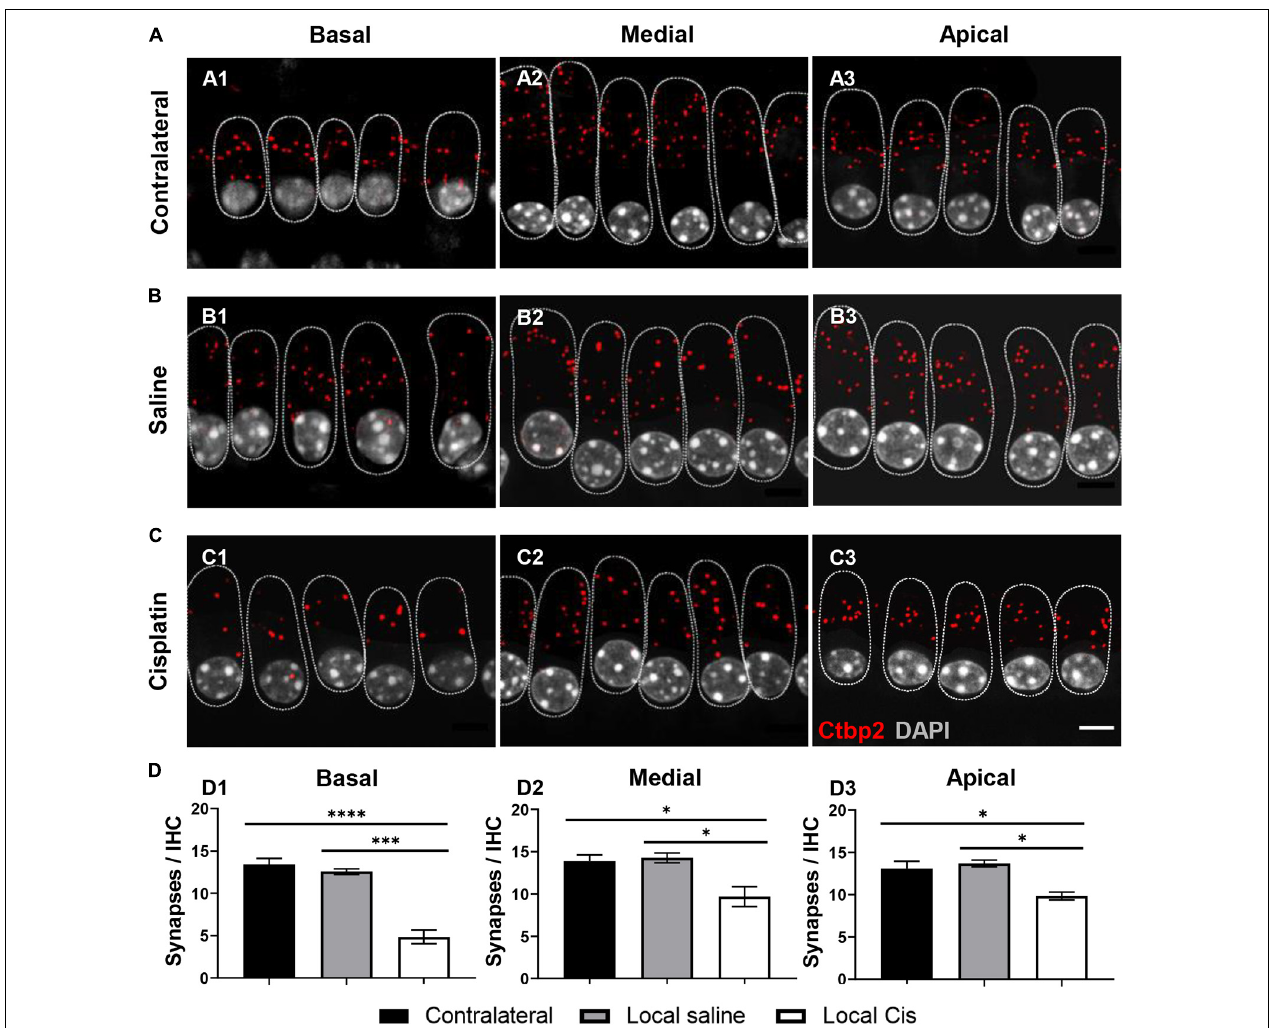
FIGURE 4 | Effect of cisplatin local delivery on number of synapses/IHC. IHC from (A) contralateral, (B) saline, and (C) local-cisplatin (5 mM) cochleas were stained with DAPI (nucleus, white), Ctbp2 (ribbon synapsis, red dots), and myosin VIIa (HCs, substituted by dotted lines to facilitate visualization). (A1–C1) Basal, (A2–C2) medial, and (A3–C3) apical cochlear turns. (D) Bar graphs show number of presynaptic ribbons/IHC in apical (D1) , medial (D2) , and basal (D3) turns of cochlea (without subgroup distinction). MyoVIIa staining was replaced with a dotted line, highlighting IHC area, to facilitate Ctbp2 visualization. Scale bar: 5 µ m. n = 11. The confidence interval for both statistics was set as 95% ( a = 0.05); ∗ p < 0.05; ∗∗∗ p < 0.005; ∗∗∗∗ p <